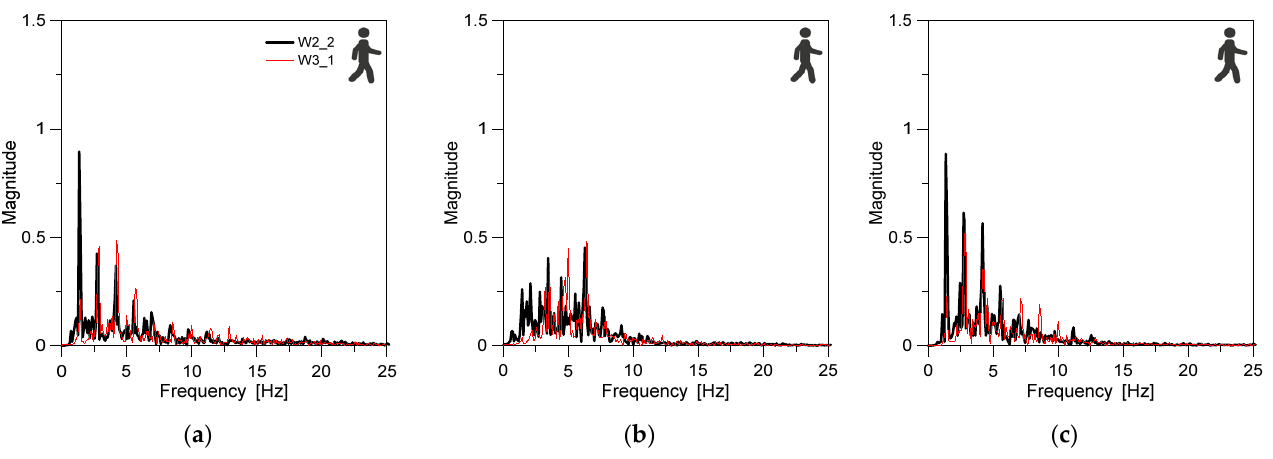
Figure 8. Example of experimental body CoM accelerations in time (W2 selection) for the volunteer moving on SLAB#1.